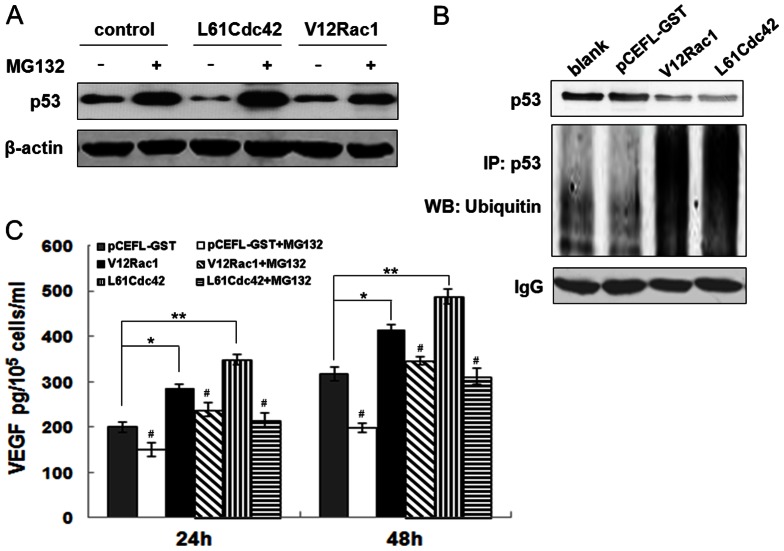
Effect of MG132 on VEGF and p53 expression induced by active Rac1/Cdc42.(A) GST–MCF-7, V12Rac1–MCF-7, and L61Cdc42–MCF-7 cells were incubated, and MG132 was added to select samples for 12 and 24 h, respectively. After incubation, the media were analyzed for VEGF levels using ELISA assay; cell numbers were counted. Data are expressed as the mean ± standard deviation (SD) for three independent experiments. Statistical significance was assessed with one-way ANOVA and Student's t-test. *P<0.05, **P<0.01, for the GST–MCF-7 group vs V12Rac1– or L61Cdc42–MCF-7 group. #P<0.05, ##P<0.01, for the MG132-added group vs the no-MG132-added group. (B, C) MCF-7, GST–MCF-7, V12Rac1–MCF-7 and L61Cdc42–MCF-7 cells were incubated, and MG132 was added to select samples for 24 h. After incubation, the cells were analyzed by western blot assay. p53, p21 and β-actin expression was examined. β-actin protein levels were used as a loading control. (D) The immunoprecipitation assay was performed as described in Material and Methods. Total protein was extracted from MCF-7, GST–MCF-7, V12Rac1–MCF-7 and L61Cdc42–MCF-7 cells and subjected to an immunoprecipitation assay. p53 protein expression was examined. β-actin protein levels were used as a loading control.